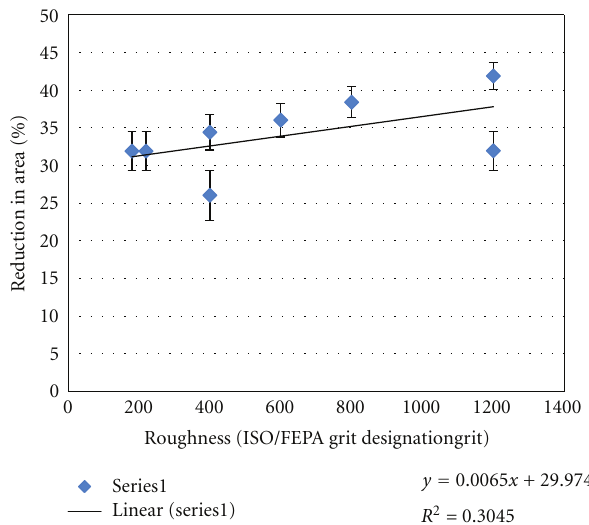
Figure 14: Slow strain-rate test results showing the influence of the surface roughness on the stress-corrosion resistance of steel at 45 ◦ C and 800kPa.